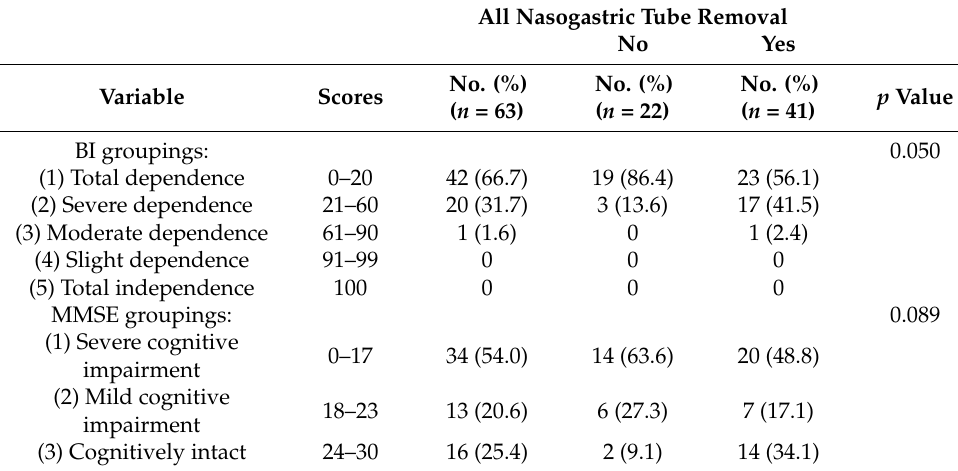
Table 2. Baseline data of the BI and MMSE groups.